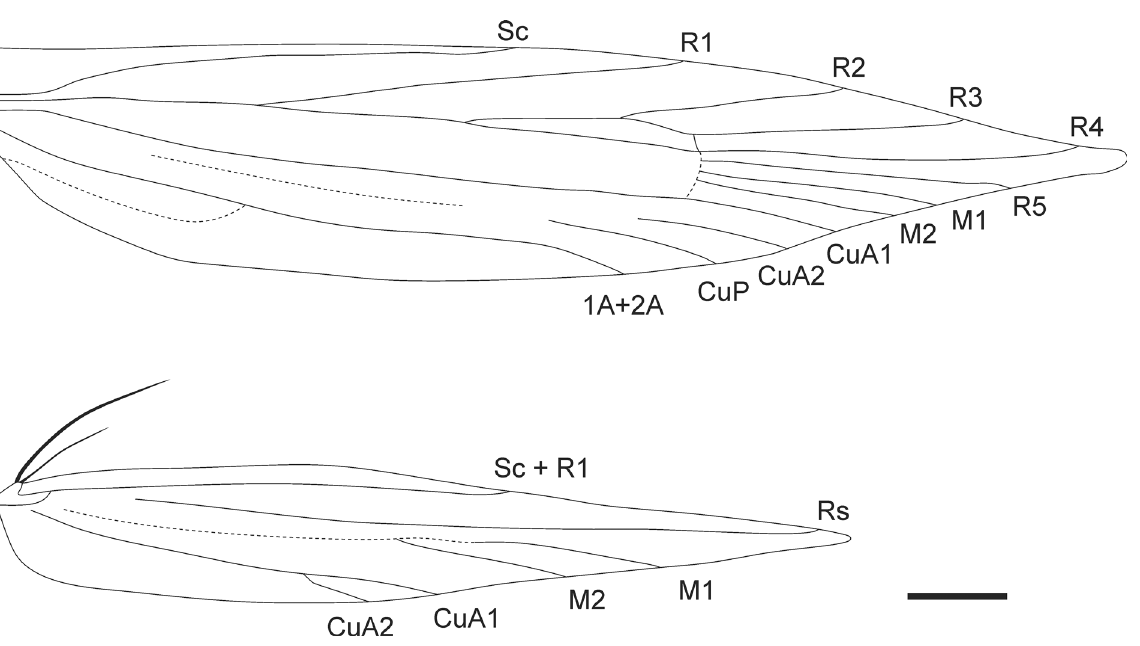
Fig. 4. Helioandesia tarregai gen. et sp. nov., ♀, paratype (IDEA-LEPI-2020-024), wing venation showing frenulum with two bristles of unequal length. Scale bar: 1